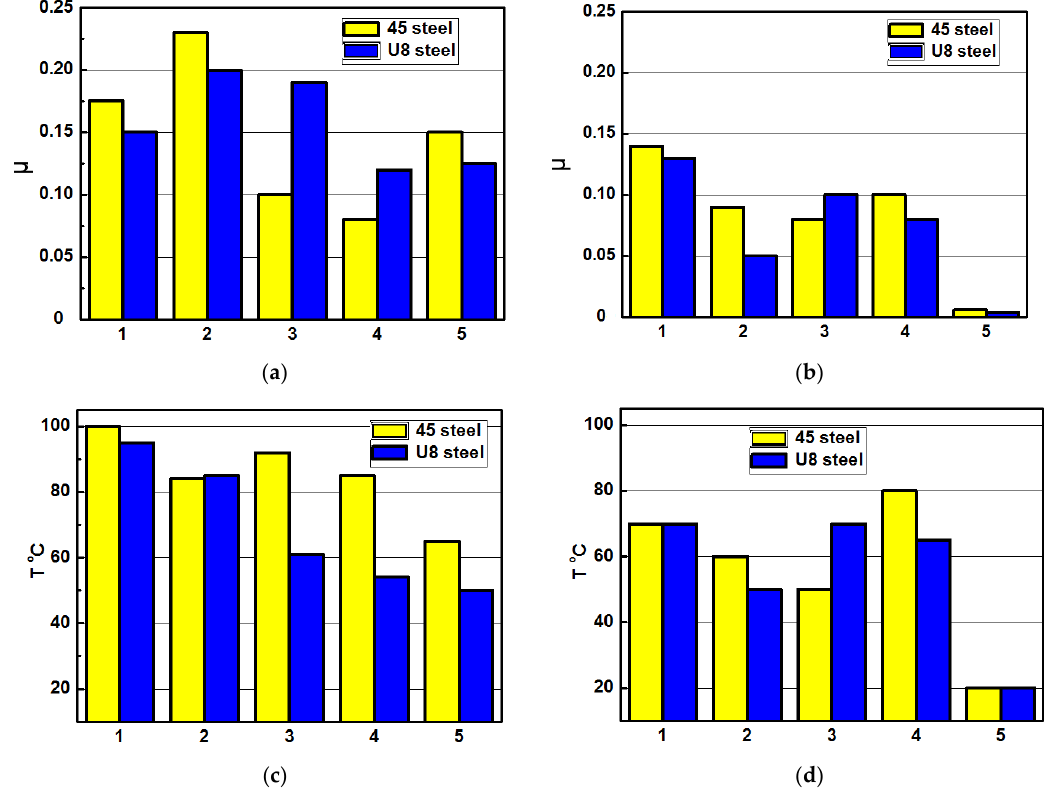
Figure 6. Averaged values of the friction coefficients ( a,b ) and the heating temperatures in the vicinity of the tribocontact zones ( c,d ) between the PEO layers synthesized on the AMg-6 ( a,c ) and D16T ( b,d ) alloys and specimens from the 45 and U8 steels without hydrogenation ( 1 ), after their preliminary hydrogenation with the diffusive ( 3 ) or residual hydrogen ( 4 ) under tribo-testing in the pure mineral oil of the I-20 type, or without hydrogenation of steel specimens and with their tribo-testing in mineral oil of the I-20 type with the addition of the 0.5 vol. % distilled water ( 2 ), or of the 1.0 vol. % aqueous solution of glycerin ( 5 ). Current density during electrolytic hydrogenation of steel specimens was 2.0 A/dm 2 and the time of hydrogenation was 1.0 h. The specific load in the friction zone was 4.0 MPa. Testing time was 4.0 h.